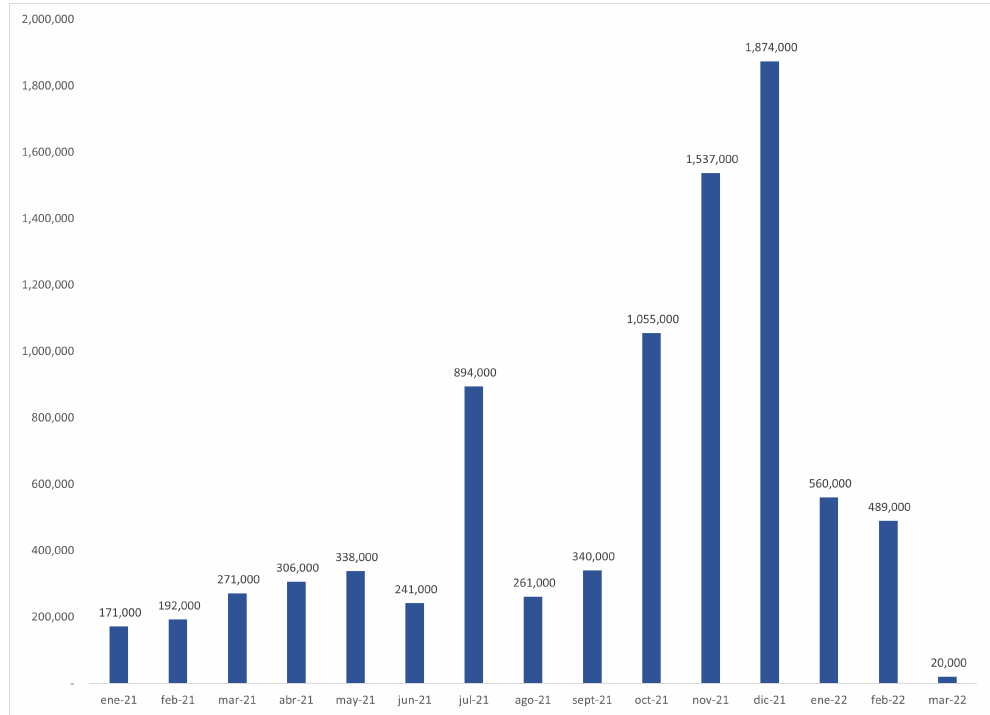
Figure 2. Number of tweets per